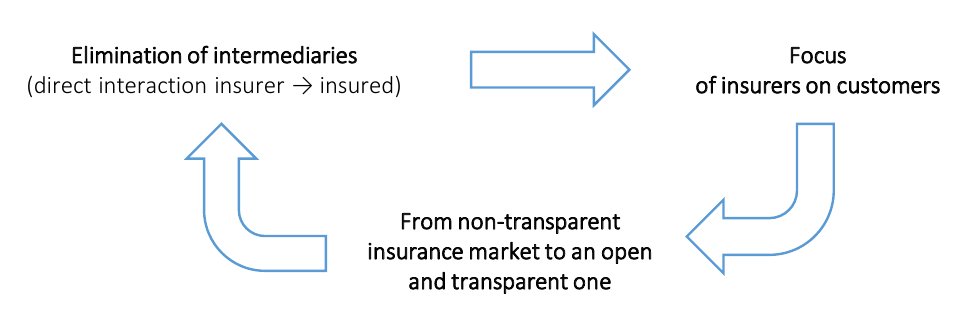
Figure 9. Consequences of the impact of digital technologies